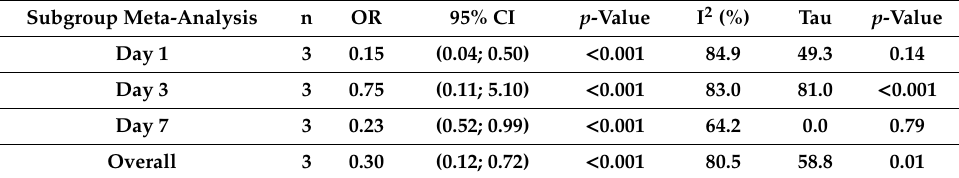
Table 4. Subgroup meta-analysis of Analgesic consumption at 1, 3 and 7 days of follow-up. Subgroup Meta-Analysis n OR 95% CI p -Value I 2 (%) Tau p -Value Day 1 3 0.15 (0.04; 0.50) < 0.001 84.9 0.14 3 0.75 (0.11; 5.10) < 0.001 0.23 (0.52; 0.99) <